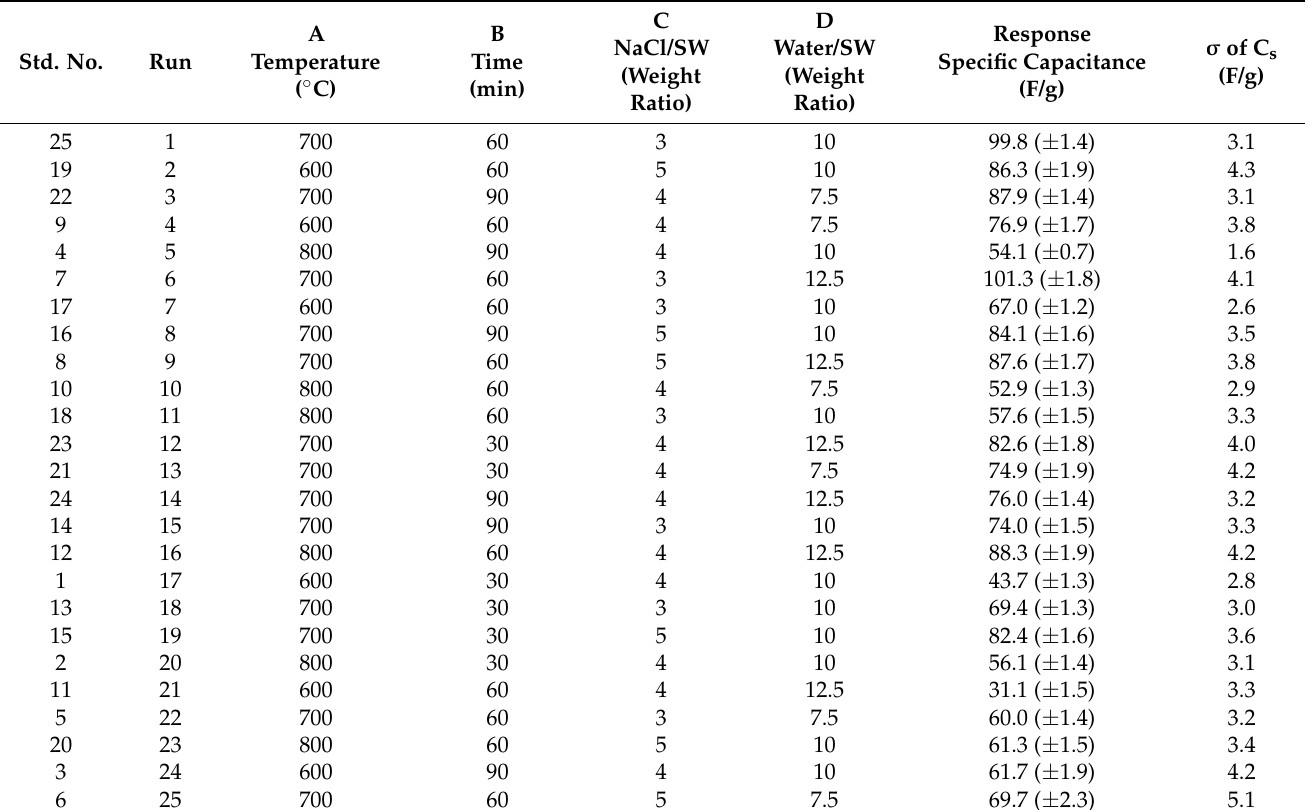
Table 2. The design of experiment (DOE) table and experimental